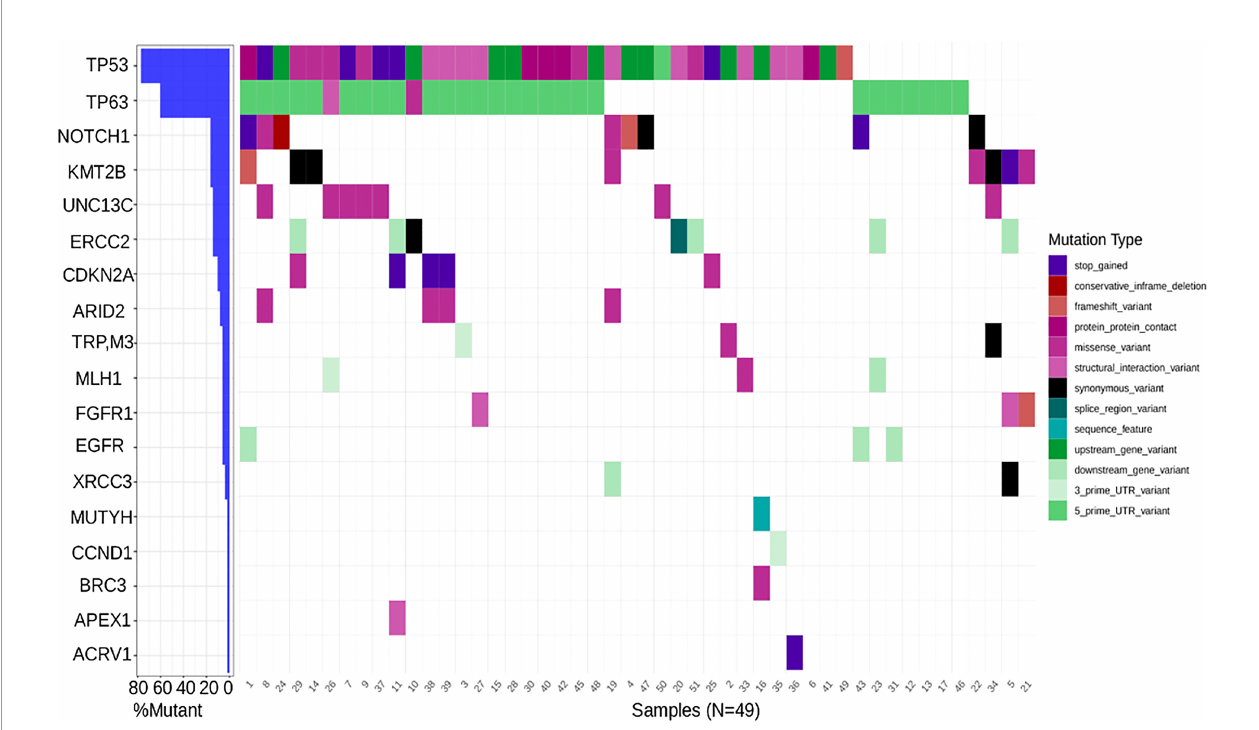
FIGURE 2 | Waterfall plot depicting mutation frequency of genes known to be implicated in HNSCC across patients with the highest frequency being that of TP53 and the lowest being that of ACRV1 along with a varying frequency across tumor suppressors, cell cycle genes, DNA damage and repair genes